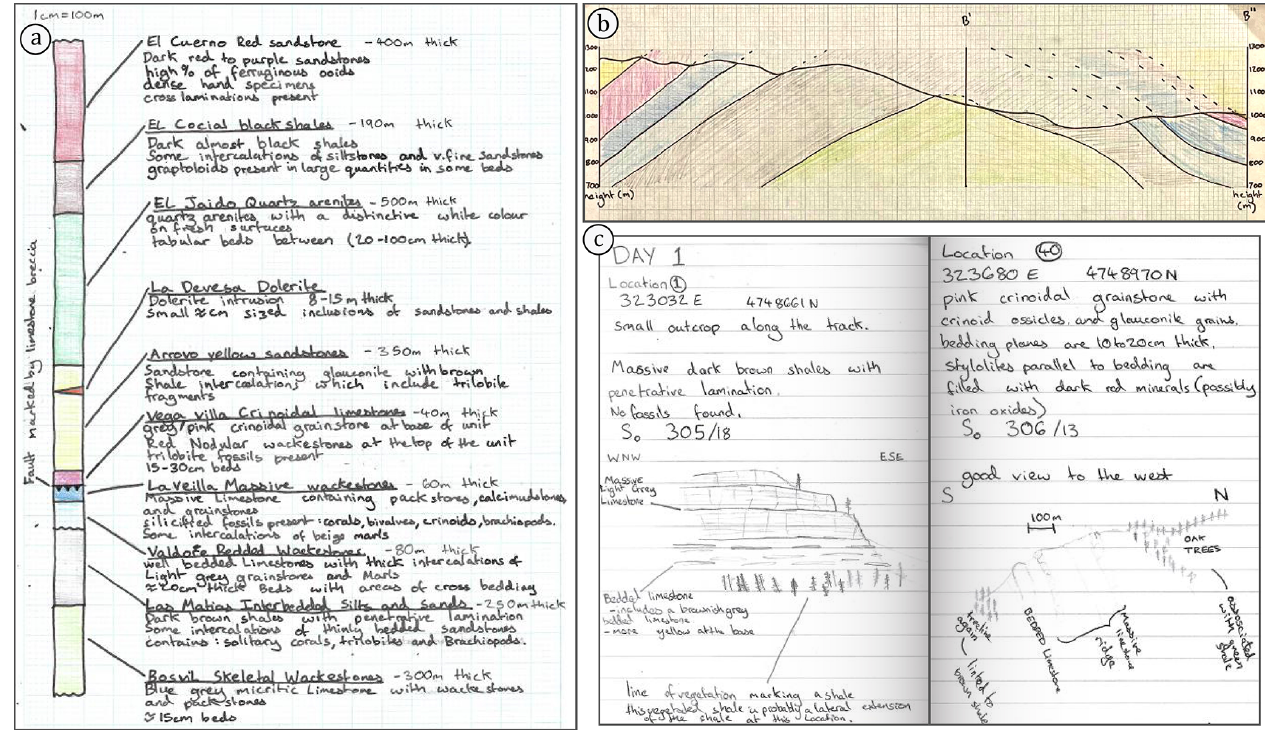
Figure 3. Tasks performed by students during of the Esla Mapping Project. (a) Stratigraphic log of the lithological units identified in the area, displayed in a tectono-stratigraphic order. (b) Cross section through the central part of the mapping area showing the Pardominos Anticline. (c) Example of field notebook pages where a student has transcribed the information provided and drawn field sketches from panoramic photographs (see Fig. 2d for comparison with the lower-right